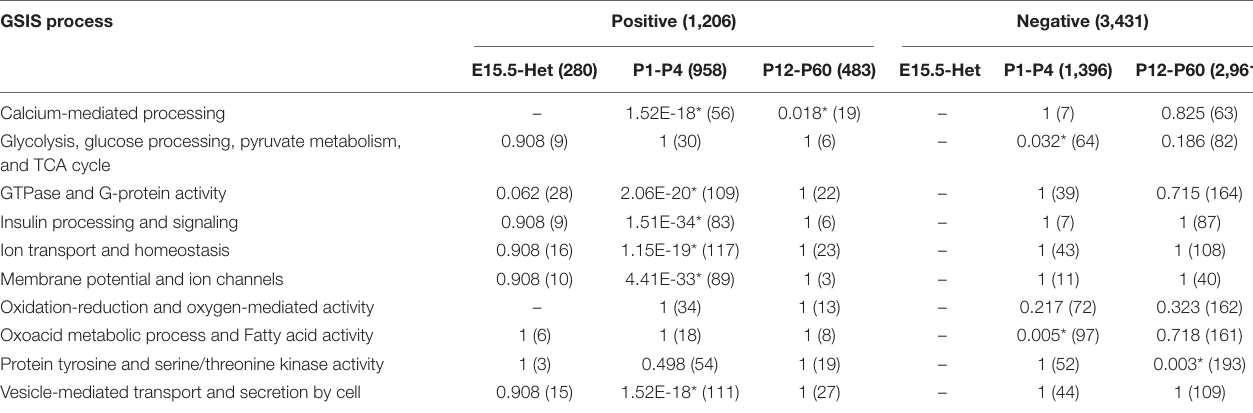
TABLE 2 | Enrichment results on GSIS processes for positive and negative MPs, according to time